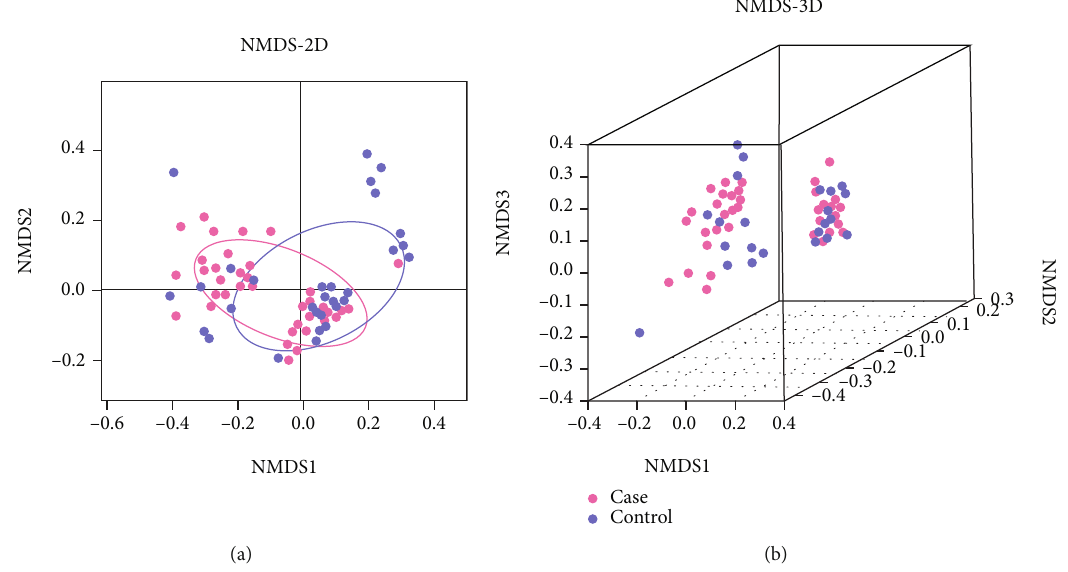
Figure 3: The analysis of NMDS by 2D and 3D models. (a) Two-dimensional map. (b) Three-dimensional map. The di ff erent β -diversity distance matrices were compared and analyzed from the original data. The 2-dimensional and 3-dimensional maps of the sample space location were obtained. It indicates an obvious di ff erence between the case and control groups when the same color samples are grouped by circle. Each dot represented one sample by pink (case group) or blue (control group) in the map. NMDS: nonmetric multidimensional